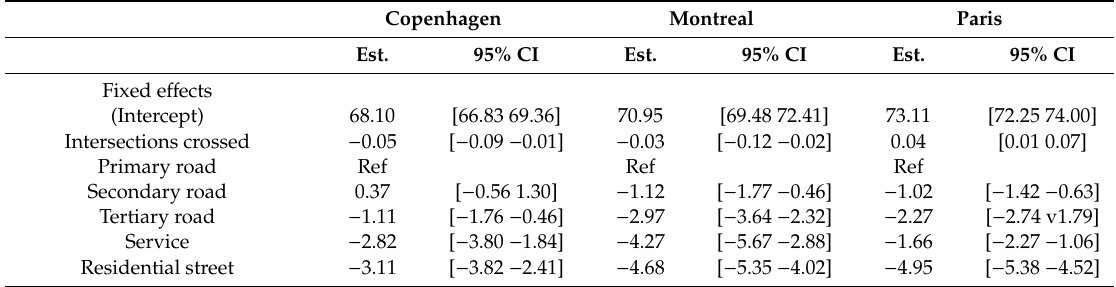
Table 2. Results of the Bayesian models for the three cities. MA, moving average; CI, confidence interval. Copenhagen Montreal Paris